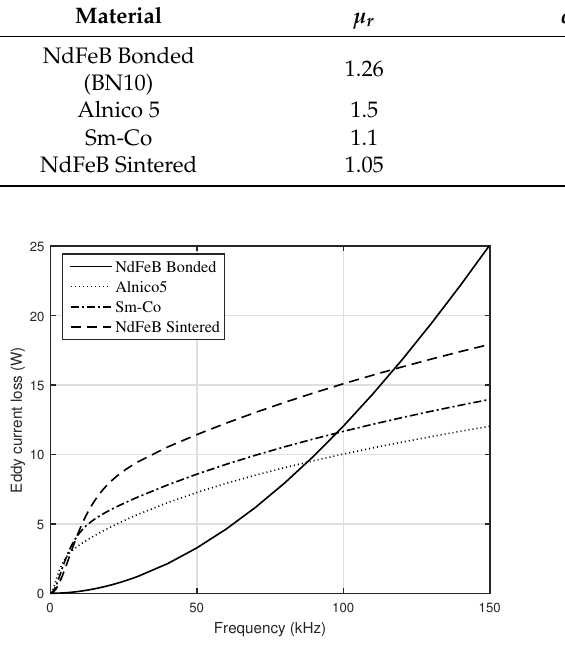
Figure 8. Magnet eddy current losses vs. frequency for a few selected magnet